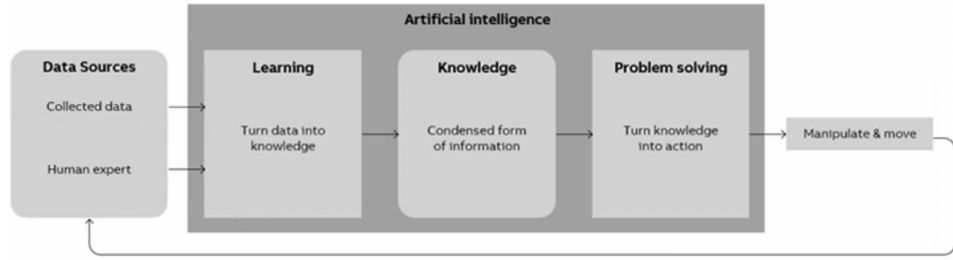
Figure 4. AI key components illustrated in the form of the closed loop control system scheme.